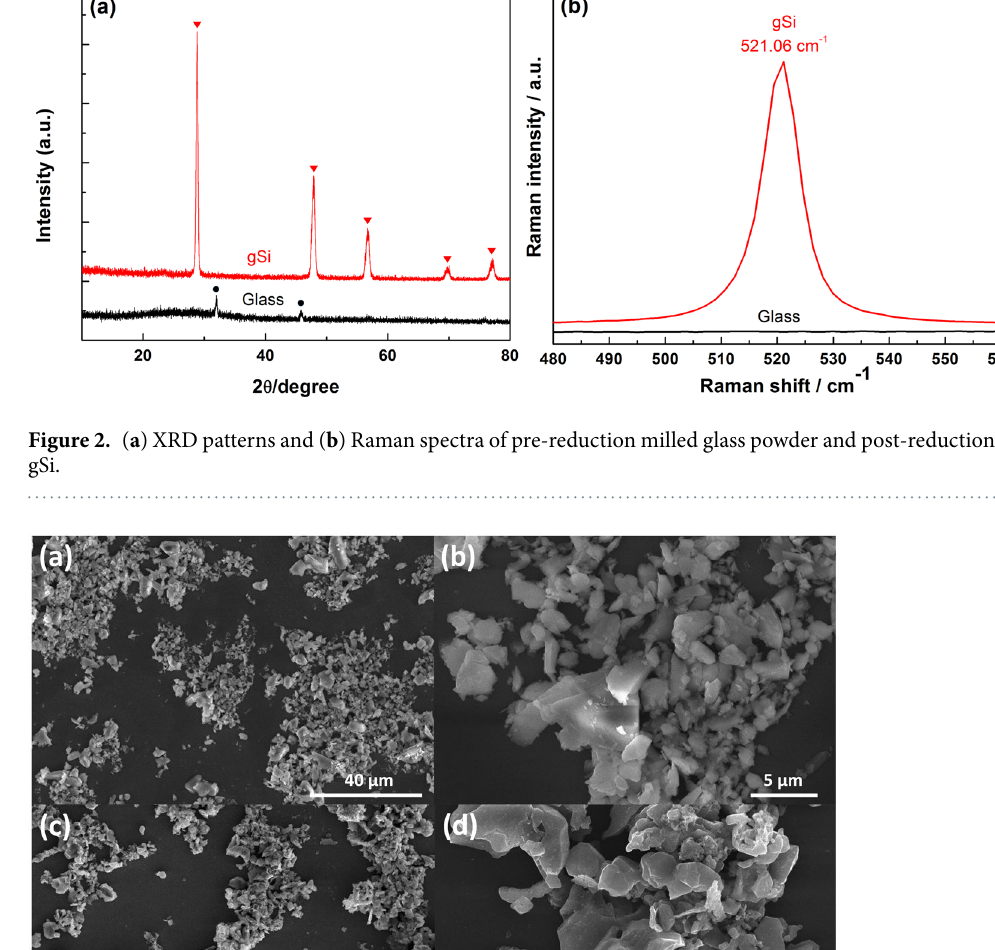
yield of gSi reduced from glass powder is close to the theoretical yield value of 46.7 wt.% (see supporting informa- tion), which offers an option for Si production on the industry level. The purities and phases of small size glass powder and as-reduced gSi are examined by X-ray diffraction (XRD) measurements in Fig. 2a. The weak XRD peaks associated with glass powder (index as black spectra) indicate the as-prepared quartz powder comprises minor by-products. The red XRD spectra of gSi demonstrates narrow and sharp peaks without amorphous scattering, suggesting the successful reduction from glass quartz to high degree crystallinity of Si. The peaks at 2 θ of 28.8°, 47.8°, 56.7°, 69.7° and 77.1° represent (111), (220), (311), (400) and (331) planes, respectively 41 . Raman spectroscopy is carried to further verify the compositions of glass powder and gSi. The sharp peak at 521.06 cm − 1 signifies the relatively high-purity of as-reduced gSi in Fig. 2b 30 . Scanning electron microscopy (SEM) micrographs are used to describe the structures and morphologies of the glass powder and gSi. The milled SiO 2 powder displays a highly irregular-shape morphology with the par- ticle size ranging from micrometer to nanometer scale as shown in Fig. 3a,b. The quantitative analysis obtained from the Energy Dispersive X-ray Spectroscopy (EDS) of quartz powder in Fig. S1 reveals the impurities may include lime (CaO), sodium oxide (Na 2 O) and alumina (Al 2 O 3 ), which are the common mineral components for soda-lime-silica glass. After reduction, the particles remain irregular in shape owing to the morphology-protected Mg reduction process at a relatively low reaction temperature. The gSi has slightly reduced size distribution and partial porosity existing in gSi compared with the solid bulk SiO 2 in Fig. 3c,d. This resulting cross-linked gSi net- works with void spaces are attributed to the breakdown of the large particles during reaction, while acid-etching to remove MgO and Mg 2 Si within the original solid structure. EDS in Fig. S2 shows the weight occupancy of